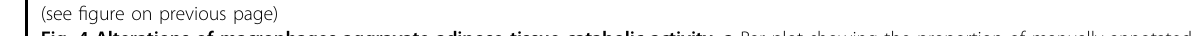
Fig. 4 Alterations of macrophages aggravate adipose tissue catabolic activity. a Bar plot showing the proportion of manually annotated macrophages in all immune cells isolated from the scRNA-seq data. Bars indicate means ± SEM. P -values were determined by unpaired Student ’ s t - test. *** P < 0.001. b The proportion of macrophages in SVF of inguinal and eWAT in both control and C26 mouse model group (animals implanted with C26 colon adenocarcinoma cells) determined by fl ow cytometry. Bars indicate means ± SEM. ns, not signi fi cant. *** P < 0.001. c The scatter plot showing the positive correlation between the proportion of macrophages in eWAT and the weight of eWAT of mouse model. Linear regression and Pearson ’ s correlation test with 95% CI were performed and the line of best fi t was shown in the plot. d Volcano plot showing the DEGs between macrophages from patients with or without cachexia in scRNA-seq data. Red dots represented the selected genes of interest with signi fi cant upregulation during CAC, whereas blue dots were downregulated genes. e , f Bar plots showing the tumor-free weight ( e ) and the weight of inguinal and eWAT ( f ) of mice in control group (animals with no tumor cell implanted), C26 group (animals implanted with C26 tumor cells and treated with control liposomes) and C26 + clodronate group (animals implanted with tumor cells and treated with clodronate-liposomes). Bars indicate means ± SEM. * P < 0.05. ( n = 6 – 8/group). g Bar plot showing the concentration of serum non-esteri fi ed fatty acids. * P < 0.05. ( n = 5 – 6/group). h Representative images of H&E staining for epididymal WAT sections. Scale bar: 50 μ m. i Quanti fi cation of the area of adipocytes in three randomly selected fi elds from each eWAT tissue per group in H&E staining sections. The violin plot showed the density of the estimated mean diameters of each adipocyte in captured images. The inner box was bounded by the upper (75%) and lower (25%) quantiles, with the median represented by the bold horizontal line. **** P < 0.0001. j Western blot analysis of the expression of ATGL and the phosphorylation level of HSL in eWAT tissue ( n = 3/ group). k Quanti fi cation of the phosphorylation level of HSL from the results of panel j . * P < 0.05. Values are means ± SEM. l qPCR analyses showing the relative mRNA levels of IFNG , TNF , and IL6 in eWAT tissue ( n = 4 – 5/group). ** P < 0.01. All P -values were determined by one-way ANOVA with post hoc Dunnett ’ s multiple-comparison correction tests. m Western blot analysis of IFN- γ in eWAT tissue ( n =